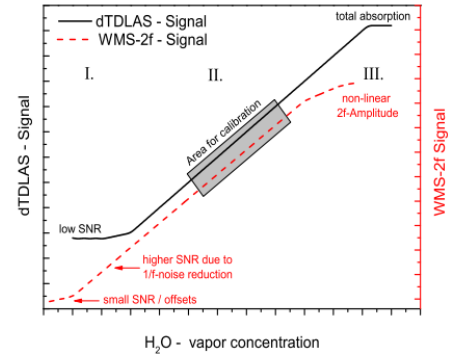
Figure 7. Schematic of the on-the-fly WMS calibration using time-multiplexed direct tunable diode laser absorption spectroscopy (dTDLAS) and WMS. Figure adapted from